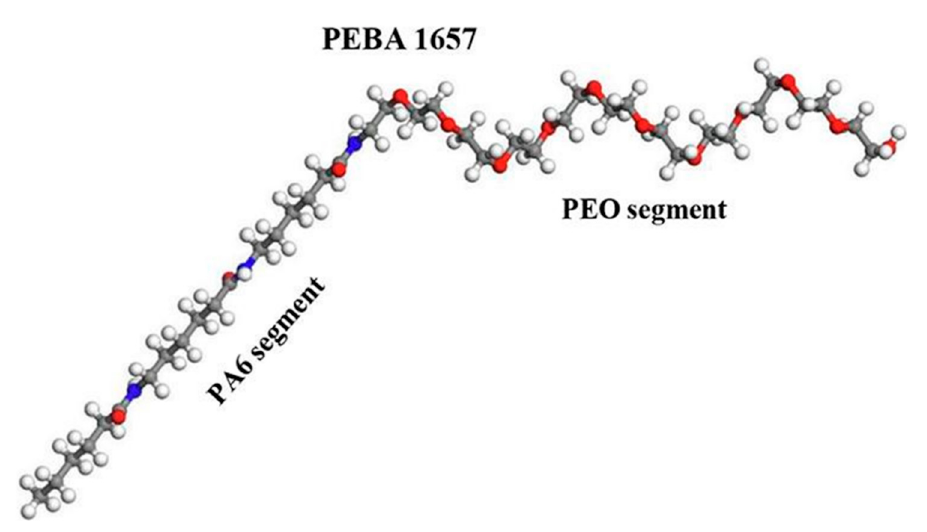
Figure 1. Structure of Pebax 1657. (Adapted from ref. [7].).